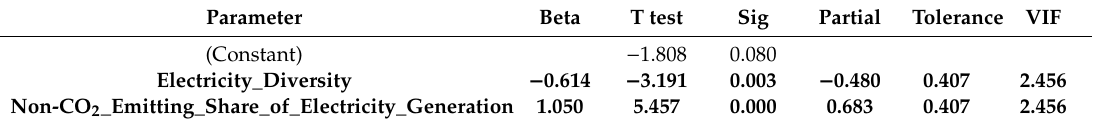
Table 15. Multicollinearity and partial correlation of parameters from the Electric Power Sector group.